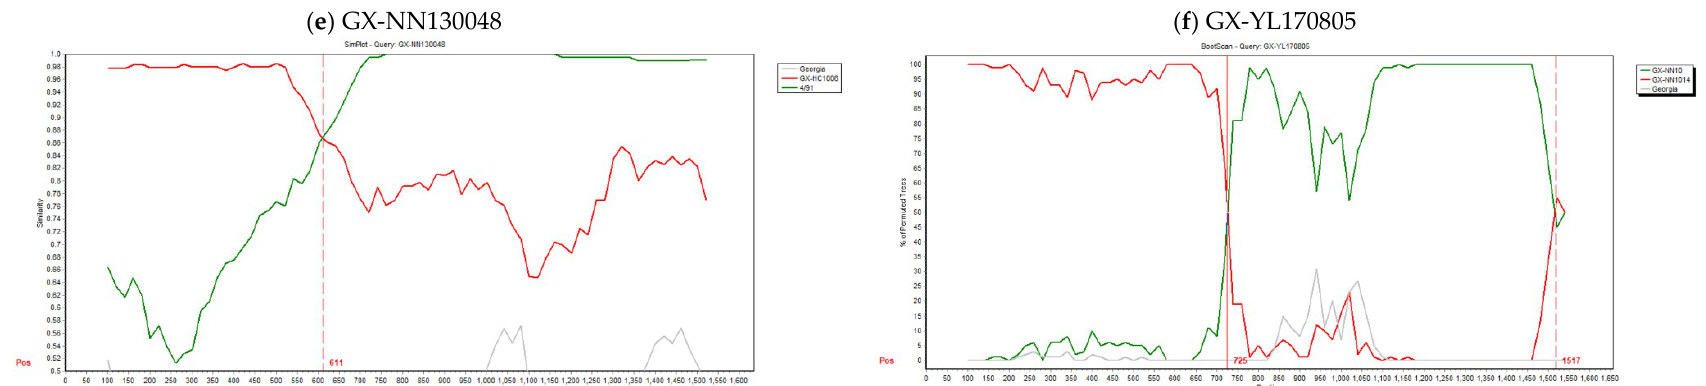
Figure 4. Similarity plots of the S1 structural gene region of GX-NN1011, GX-NN1201, GX-NN120091, GX-NN130003, GX-NN130048, and GX-YL170805 isolates created with SimPlot version 3.5.1. A 200-bp window with a 20-bp step was used. ( a ) GX-NN1011 isolate sequence used as the query, and GX-NN6 (red) and GX-NN-9 (green) used as putative parental strains. ( b ) GX-NN1201 isolate sequence used as the query, and QX (red) and SAIBK (green) used as putative parental strains. ( c ) GX-NN120091 isolate sequence used as the query, and GX-NN120089 (red) and LDT3-A (green) used as putative parental strains. ( d ) GX-NN130003 isolate sequence used as the query, and GX-YL11072 (red) and GX-YL170717 (green) used as putative parental strains. ( e ) GX-NN130048 isolate sequence used as the query, and GX-HC1006 (red) and 4 / 91 (green) used as putative parental strains. ( f ) GX-YL170805 isolate sequence used as the query, and GX-NN1014 (red) and GX-NN10 (green) used as putative parental